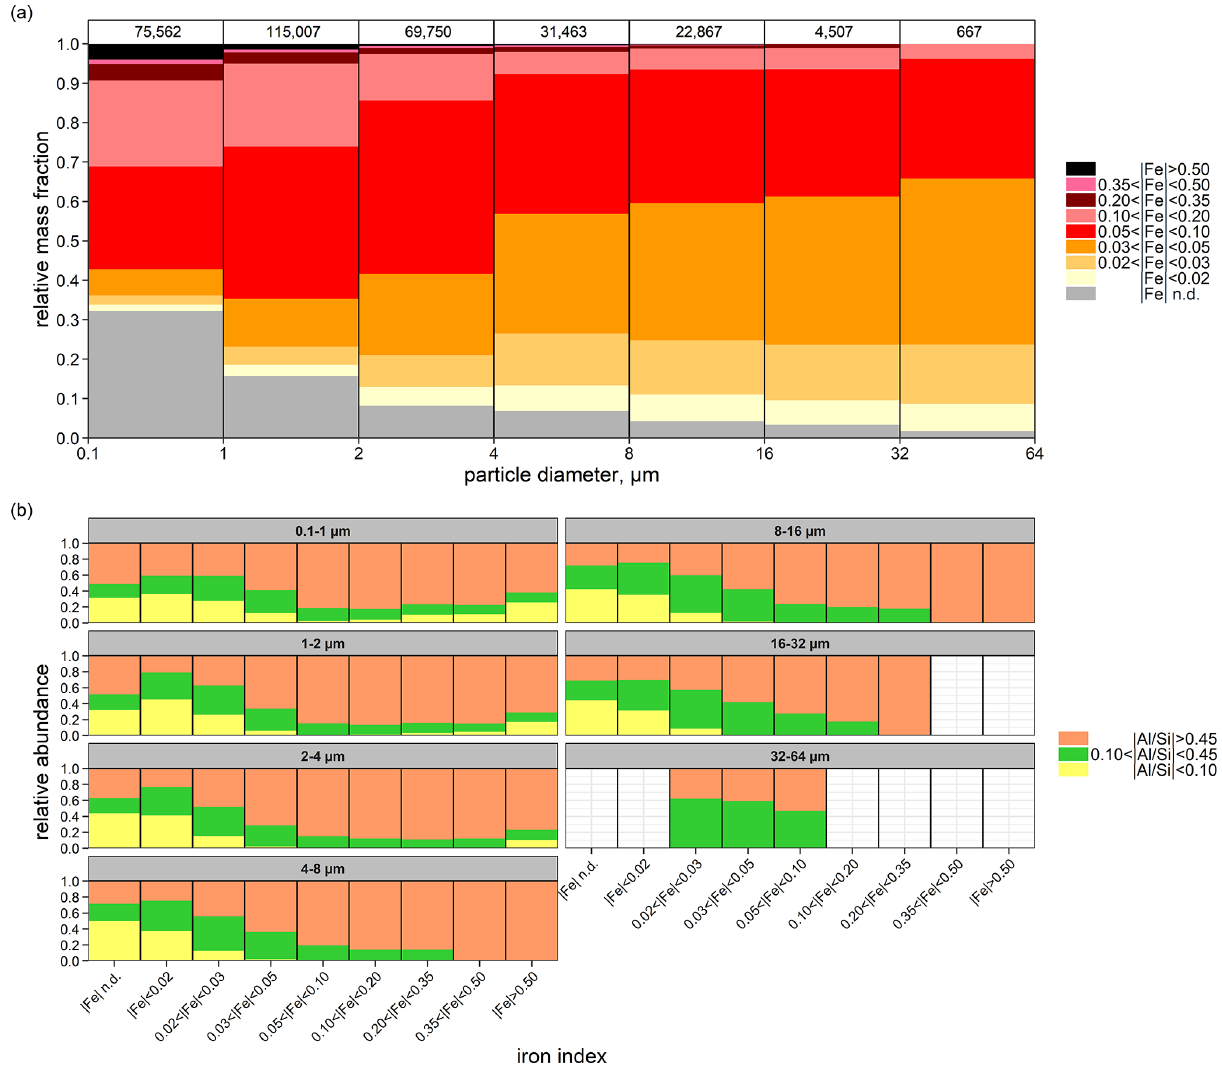
Figure 8. (a) Size-resolved iron indices for silicate particles (“n.d.” means Fe not detected). The numbers on top represent total particle counts in the given size bin. (b) Silicate particle with iron association based on Al / Si ratio. Abundance bars are not shown for size intervals with fewer than 30 particles because of their high statistical